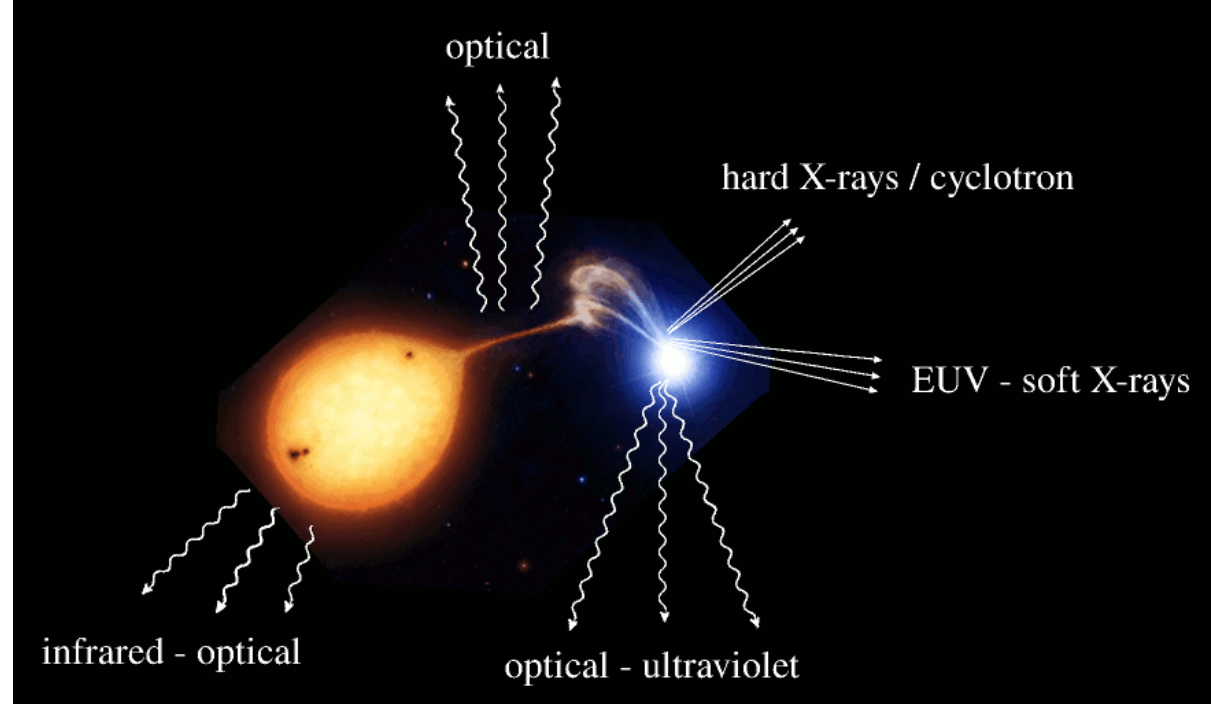
Figure 1: Schematic view of a polar and main emission regions (Iris Traulsen, adapted from Marc Garlick).